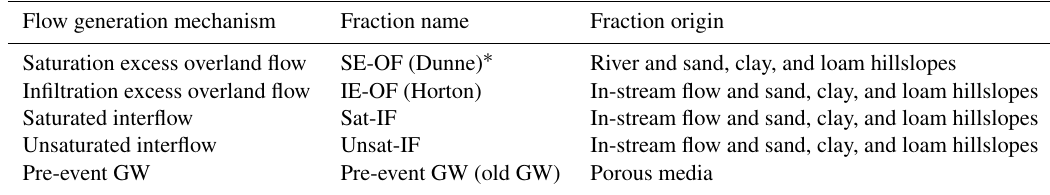
Table 2. Hydraulic mixing cell delineated fractions.